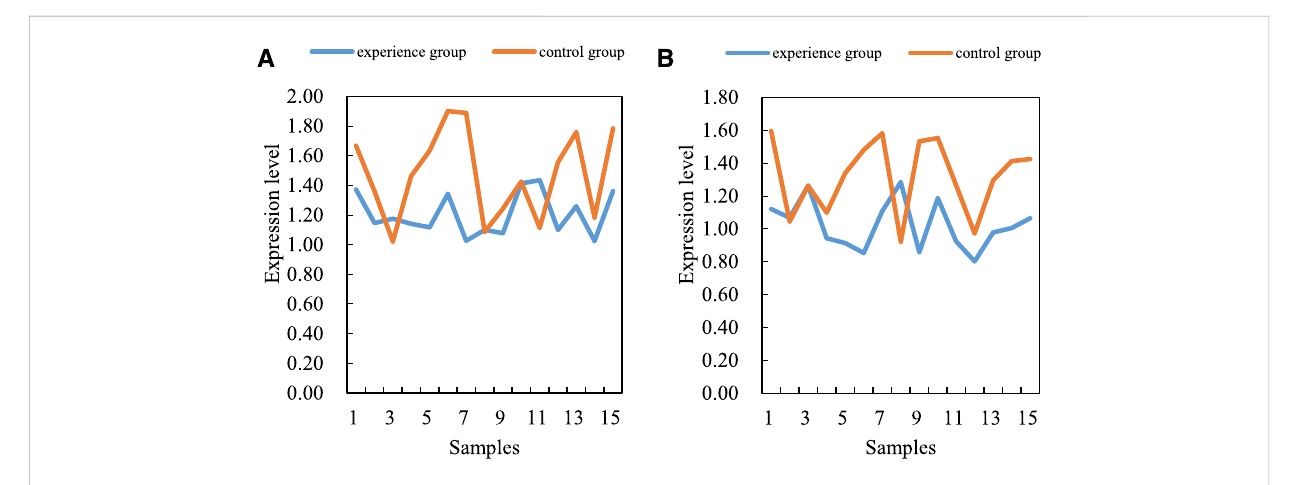
FIGURE 3 Differences in miR-206 expression levels.